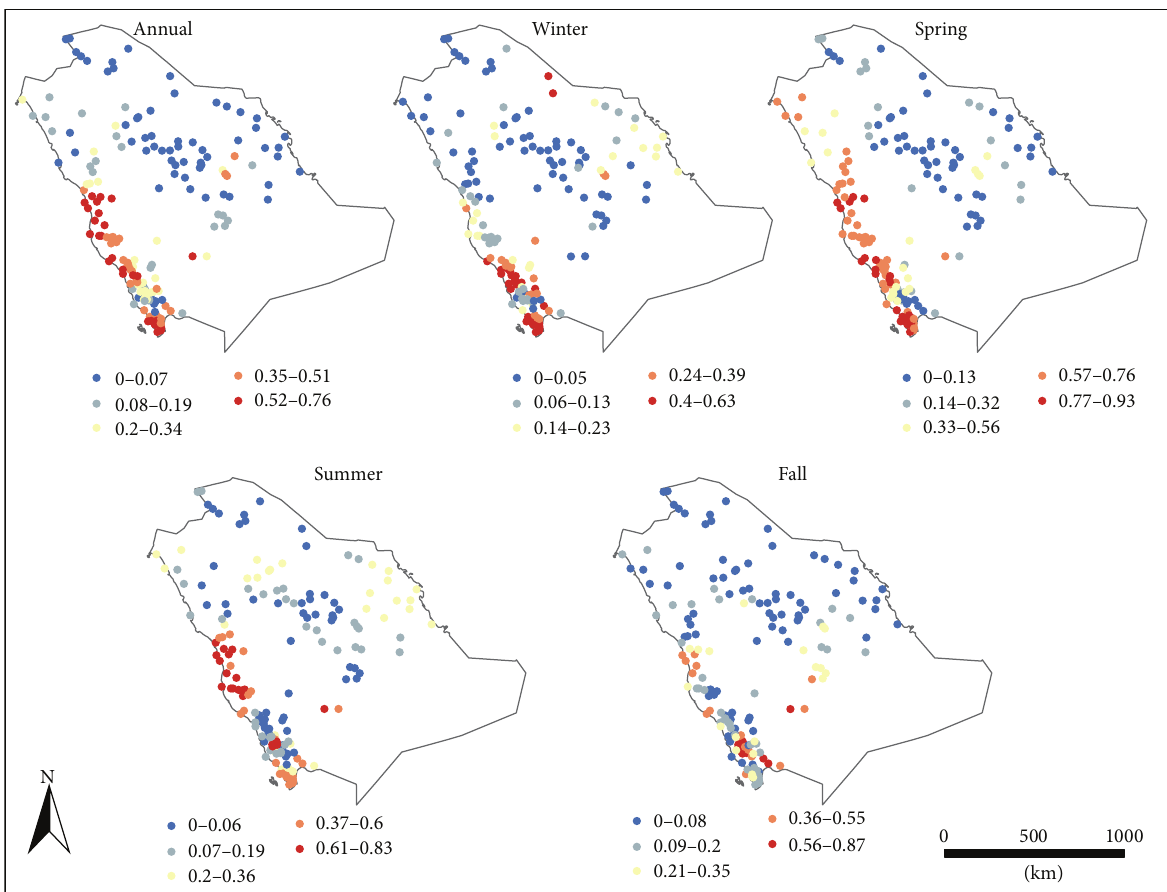
Figure 8: Locally weighted coefficients of determination (𝑟 2 ) of GWR models for annual and seasonal